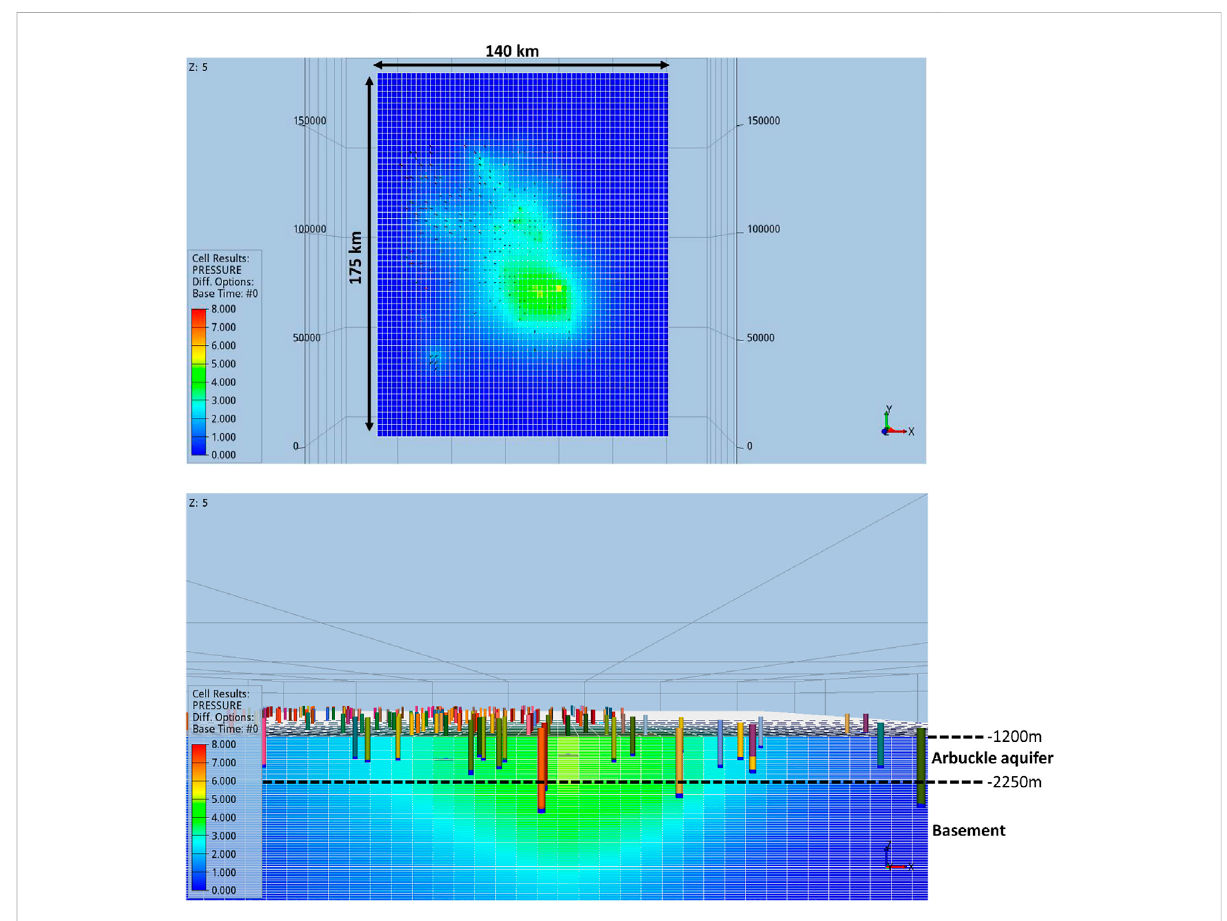
Flow simulation — visualization via ResInsight [open source visualization software, ResInsight (Computer Software), version 2020.10, part of OpenPorousMediaInitiative,CeentronSolutions,2020]ofthepressure fi eld(changesinporepressuresincethestartofinjection;inbars)attheend of 2015. Vertical exaggeration